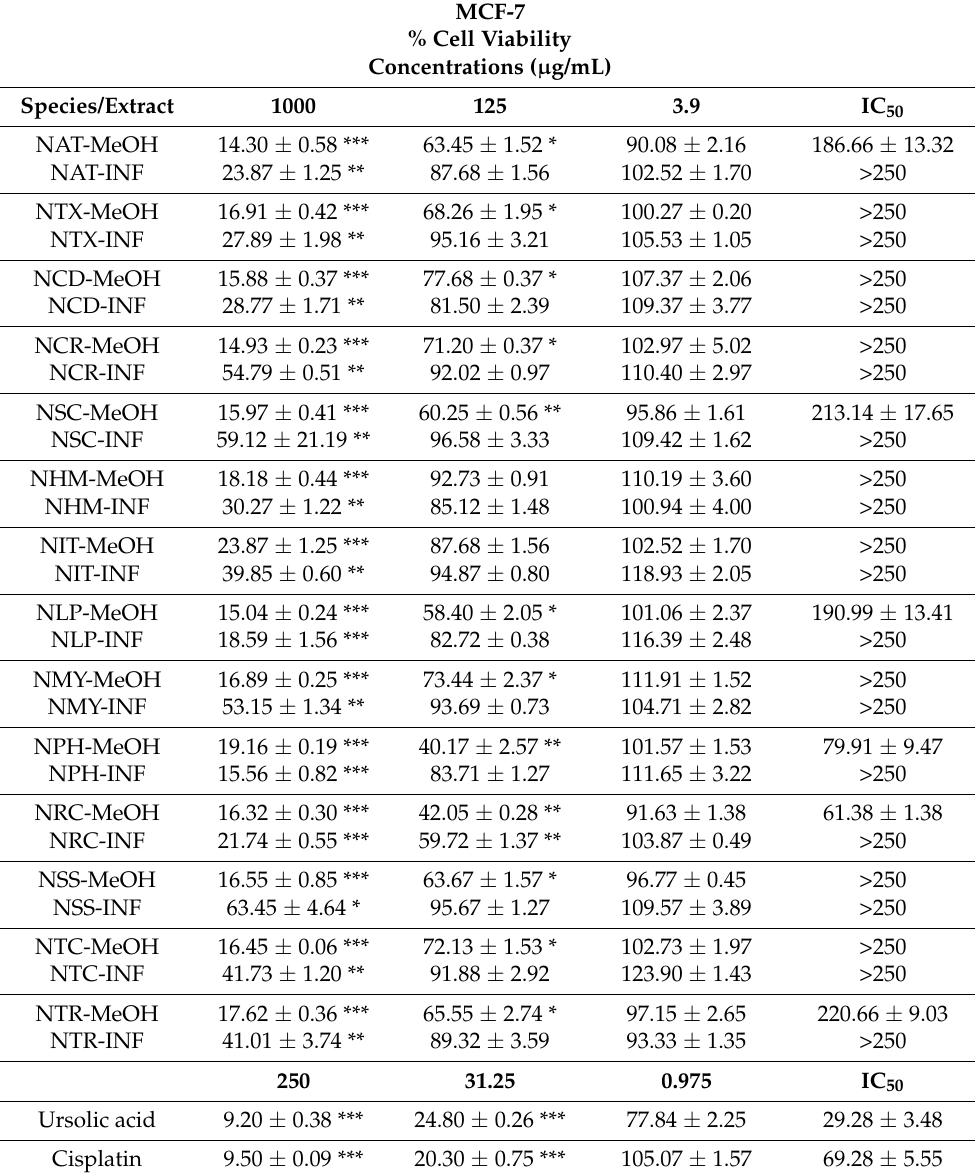
Table 2. Cytotoxic effects of Nepeta species on MCF-7 cell